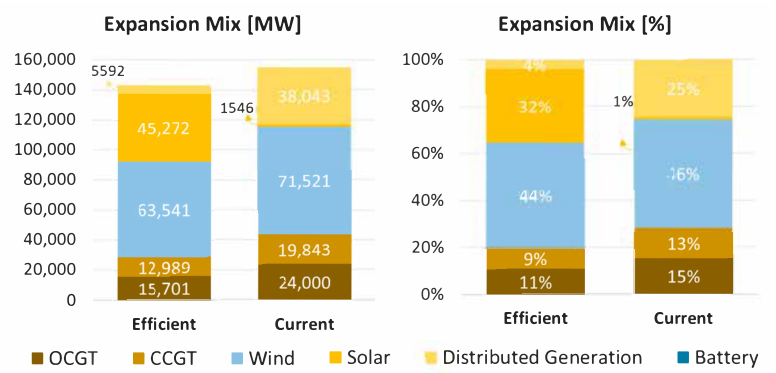
Figure 9. Comparison of total expansion between